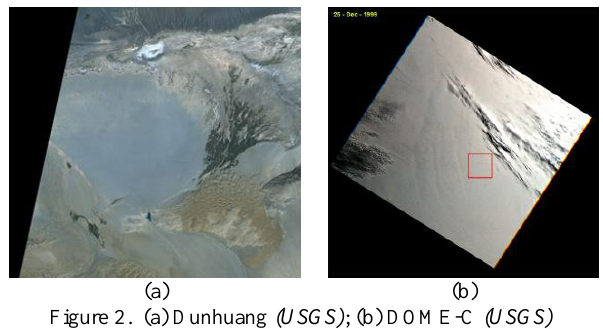
Figure 2. (a) Dunhuang (USGS) ; (b) DOME-C